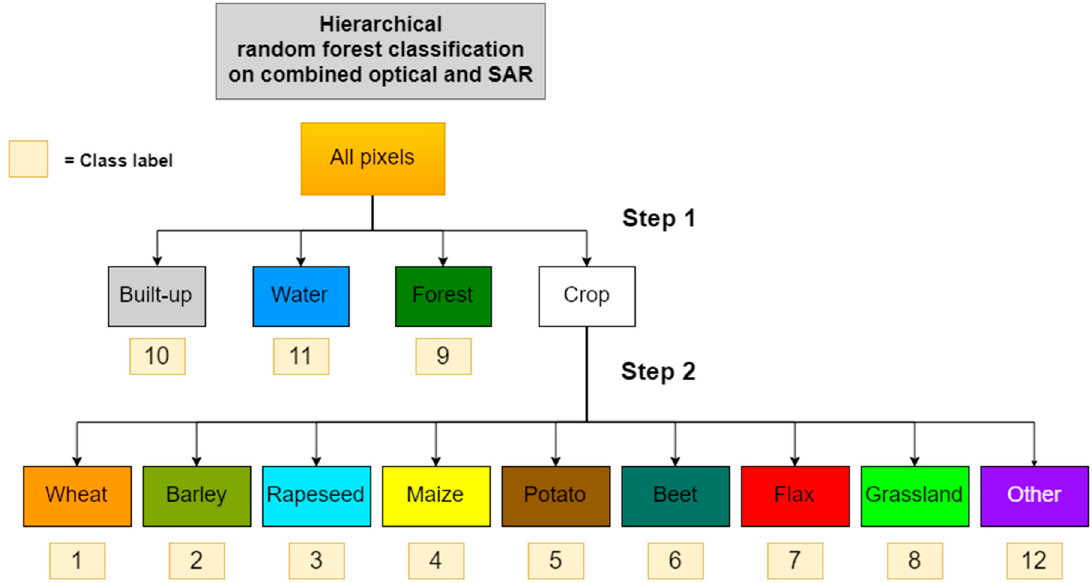
Figure 4. Schematic overview of the two-step hierarchical classification procedure. In the first step, all crop types and grassland were combined in one general crop class.